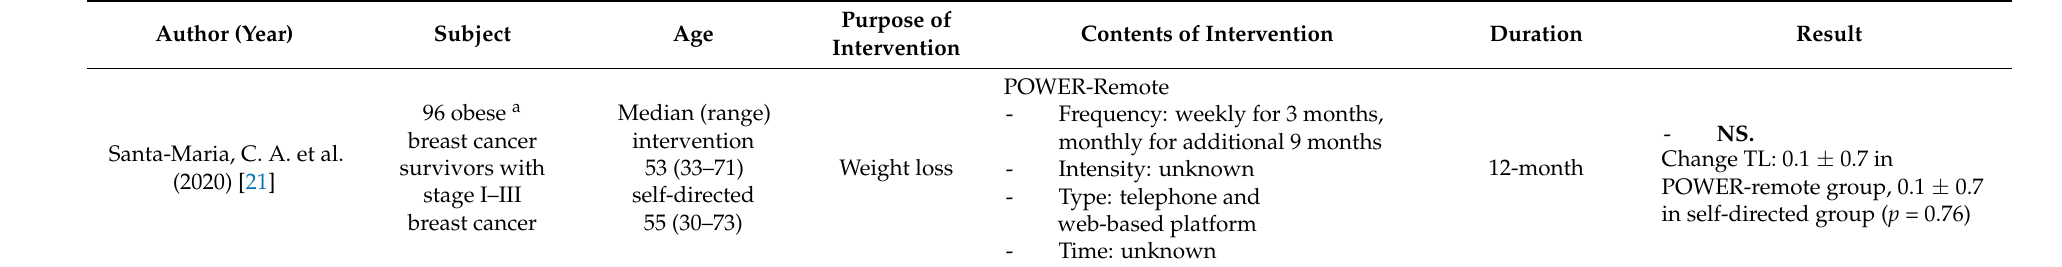
Table 2. The summary of the included randomized controlled trials